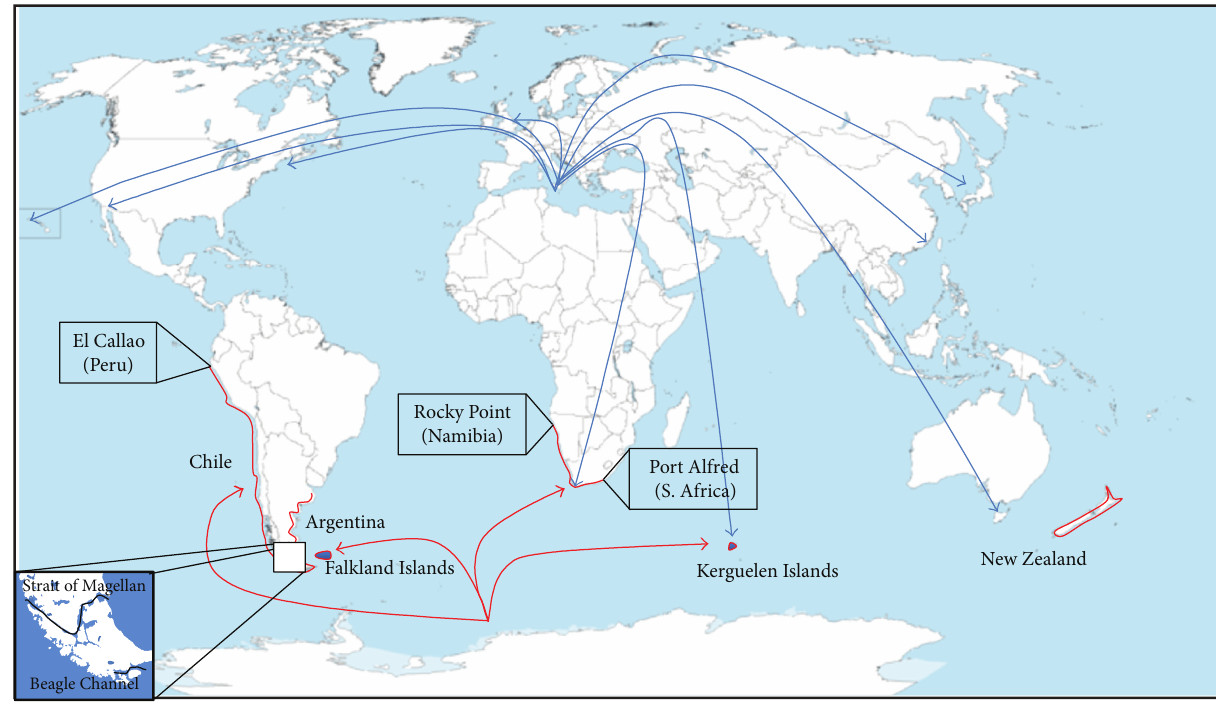
Figure 2: Global distribution of Aulacomya ater . In red, hypothetical origin of A. ater from Antarctic coasts and actual coastal distribution of A. ater . In South America, it is found in Chile, Peru, and Argentina. It is also found on the Atlantic coast of South Africa, in the Kerguelen Islands (Port-aux-Franc¸ais and other sites), New Zealand, and the Falkland Islands. In blue, invasion of the mediteraneen M. galloprovincialis worldwide (adapted from [30]). M. galloprovincialis has colonised and formed naturalised populations at nine localities outside of its native range. These include Hong Kong, Japan, Korea, Australia, America, Mexico, Canada, Great Britain, and Ireland. M. galloprovincialis has been listed as one of the World’s Worst 100 Invasive Alien Species (GISD